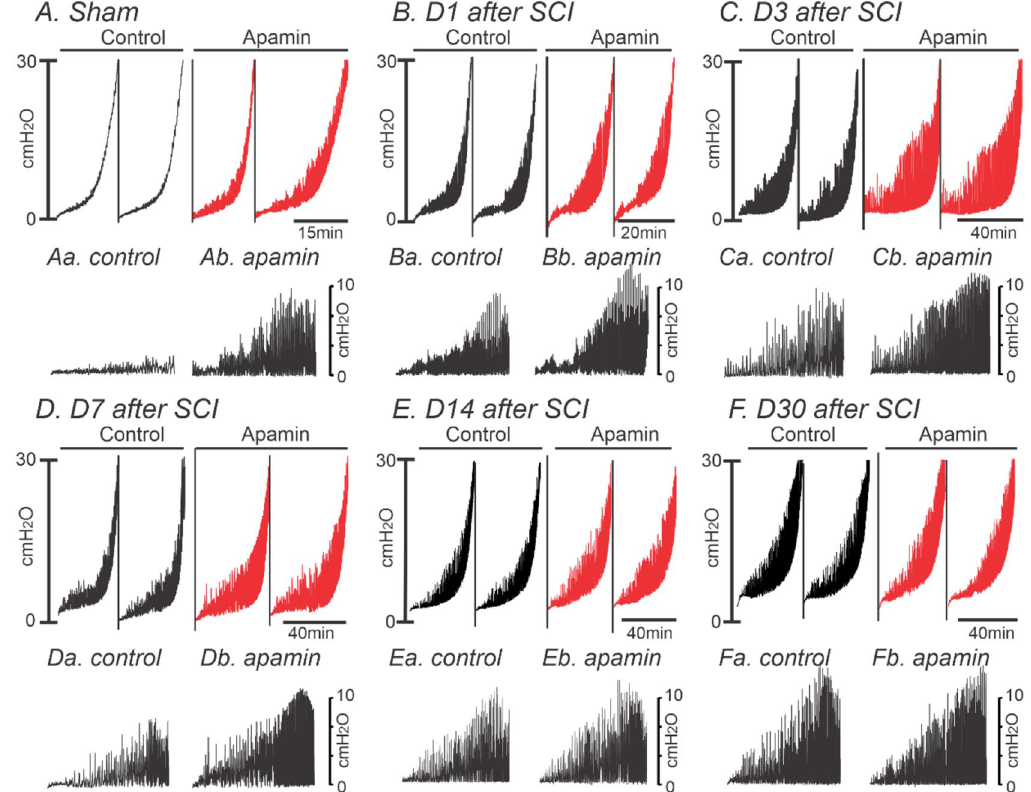
Figure 5. The effects of apamin on transient contractions (TCs) of sham, D1, D3, D7, D14 and D30 after SCI using ex vivo preparation. (A–F) Ex vivo pressure-response curve for control and apamin application. ( Aa,b– Fa,b ) Expanded time scales with adjustment of baseline under control ( a ) and apamin ( b ) from above panels.